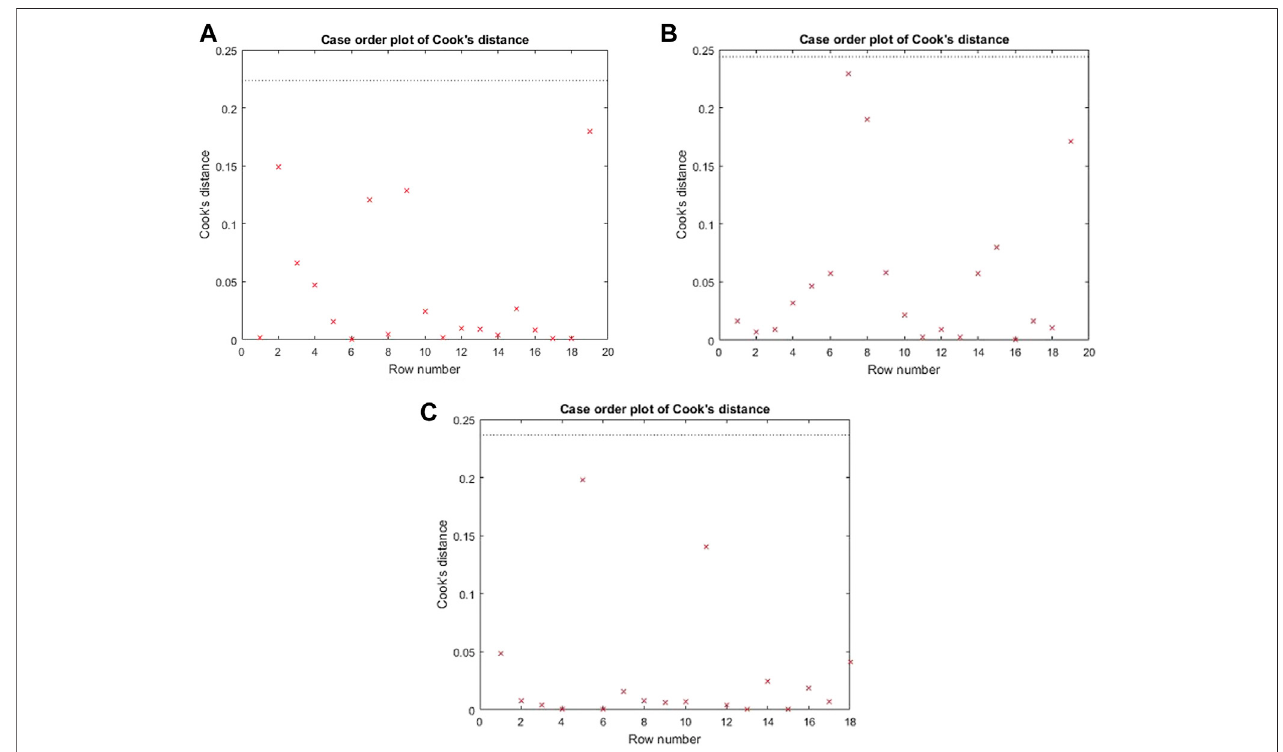
FIGURE 3 | Cook ’ s distance for (A) L. plantarum ; (B) L. casei ; (C) co-cultures of L. plantarum and L. casei